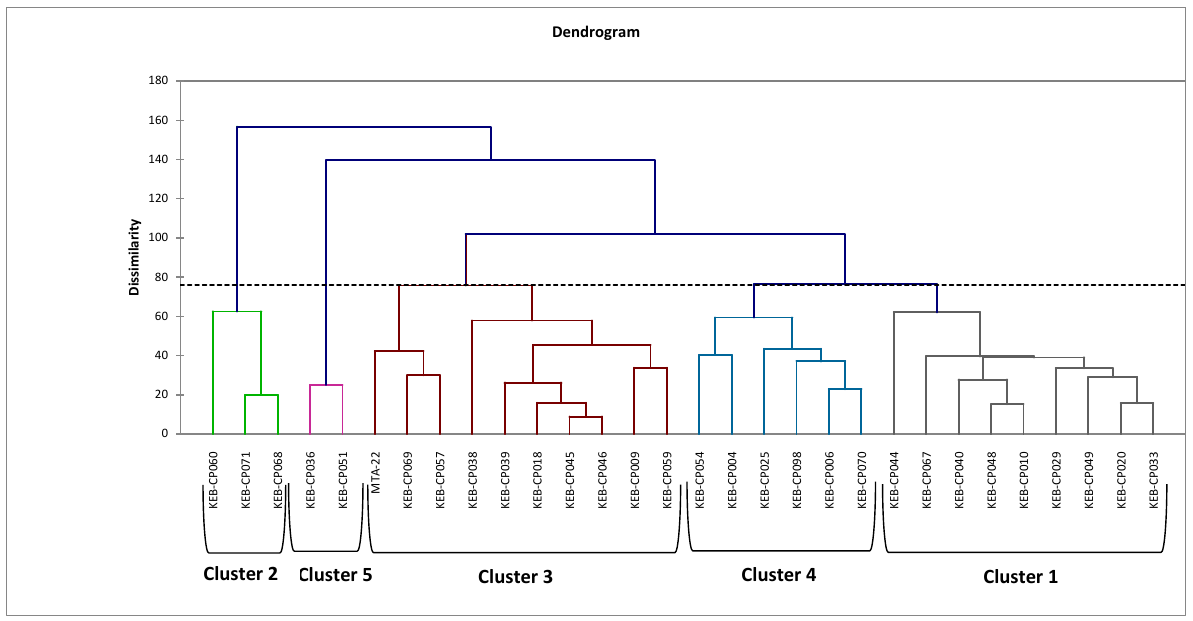
Figure 1: Dendrogram using the UPGMA method based on Euclidian distance, grouping 30 V. unguiculata accessions